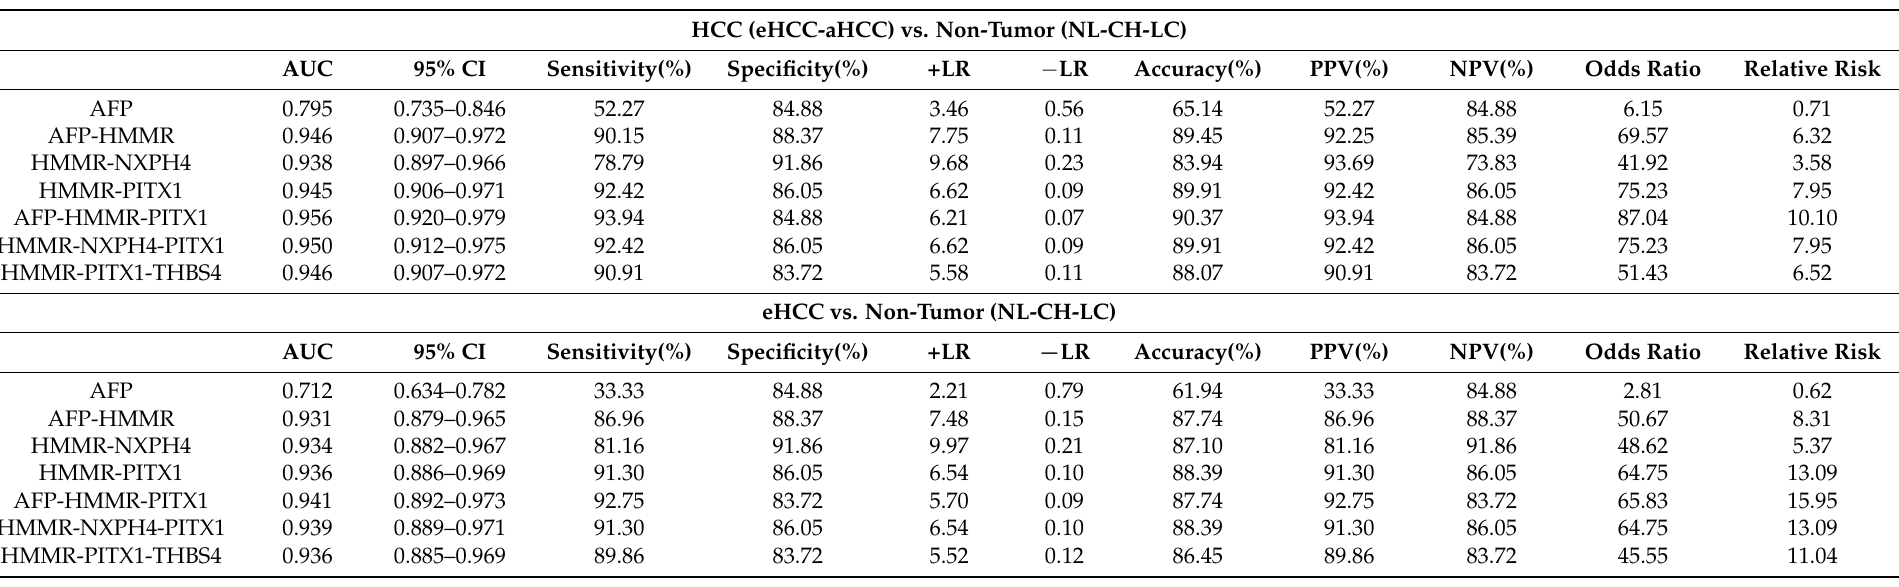
Table 2. Results for measurement of pair or triplet combinations of HMMR, NXPH4, PITX1 and THBS4 serum markers with AFP in the diagnosis of